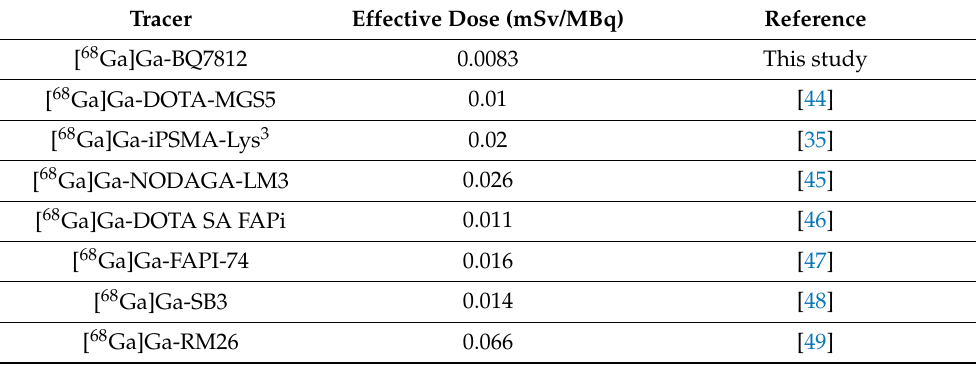
Table 2. Effective dose (mSv/MBq) of 68 Ga-labelled radiotracers reported in the literature.